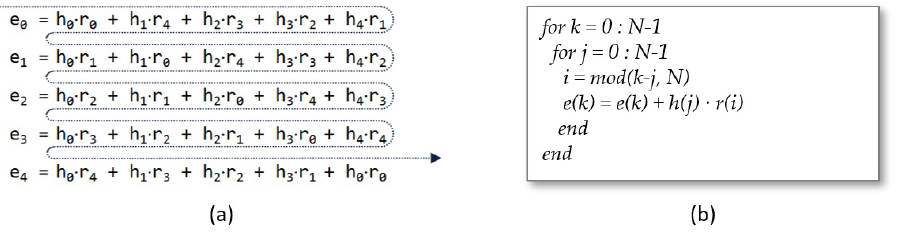
Figure 1. Evaluation of each term of the summation ( a ) and generation of indices i , j , and k ( b ) while sweeping the matrix by rows.